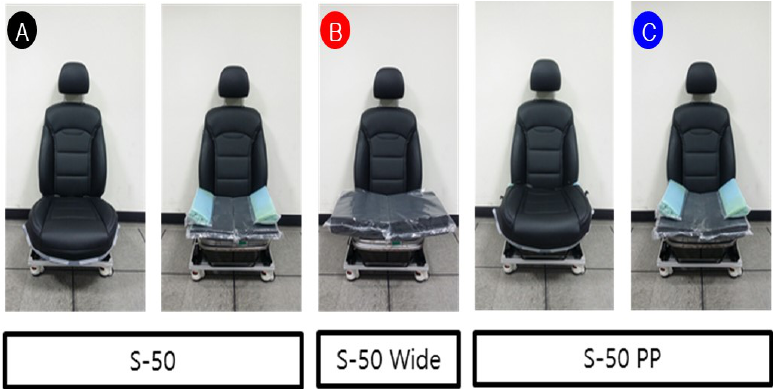
Figure 16. 3 Final models (A: S-50, B: S-50 Wide, C: S-50 PP).